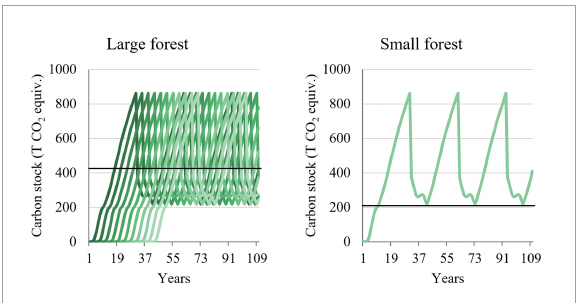
FIGURE5 Forest growth cycles for small and large forest owners. This compares forest growth cycles for large and small forest owners for a “typical” hectare, represented as changes in carbon stock (tons of carbon dioxide) over time. The “low-risk” level of NZUs is indicated with a black horizontal line. This figure illustrates data from Pinus radiata forest in Gisborne. Data from MPI (2015b).